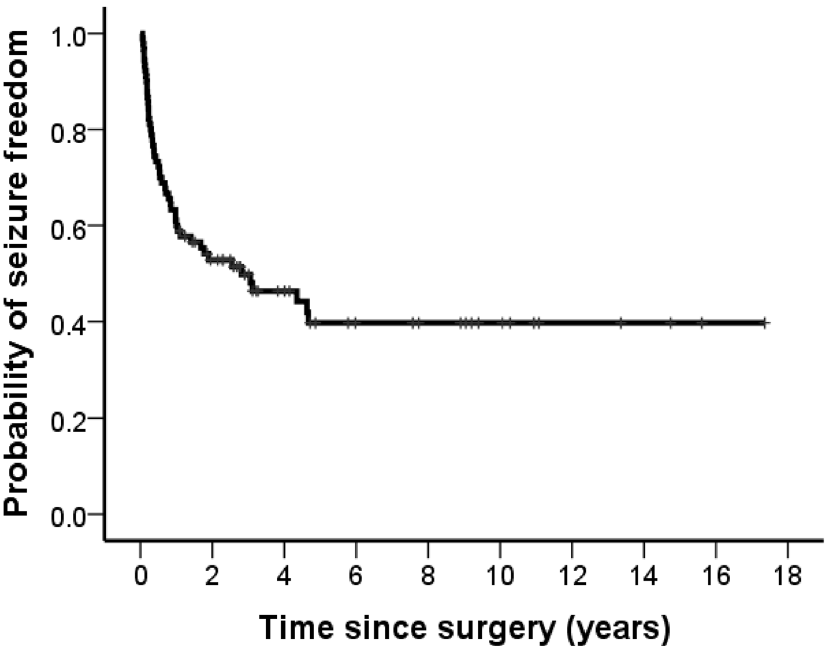
(n = 54) at 1 year, and 40% (n = 35) at 5 years.